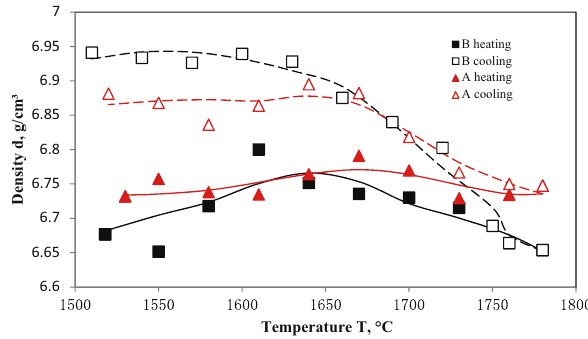
Figure 2: Changes in the density of samples A and B as a function of